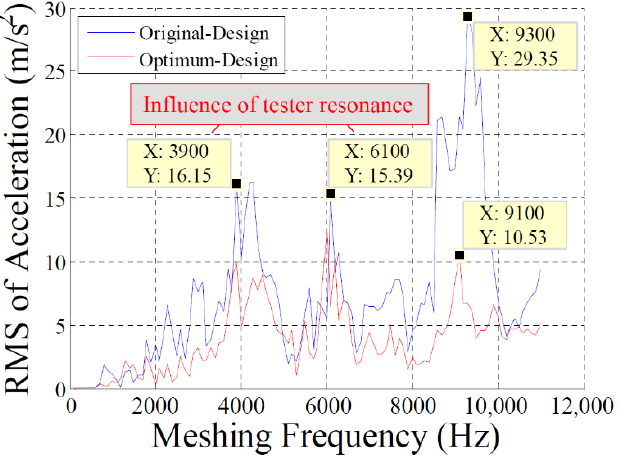
Figure 15. Experimental RMS of acceleration for original design and optimum design spur gear pairs.